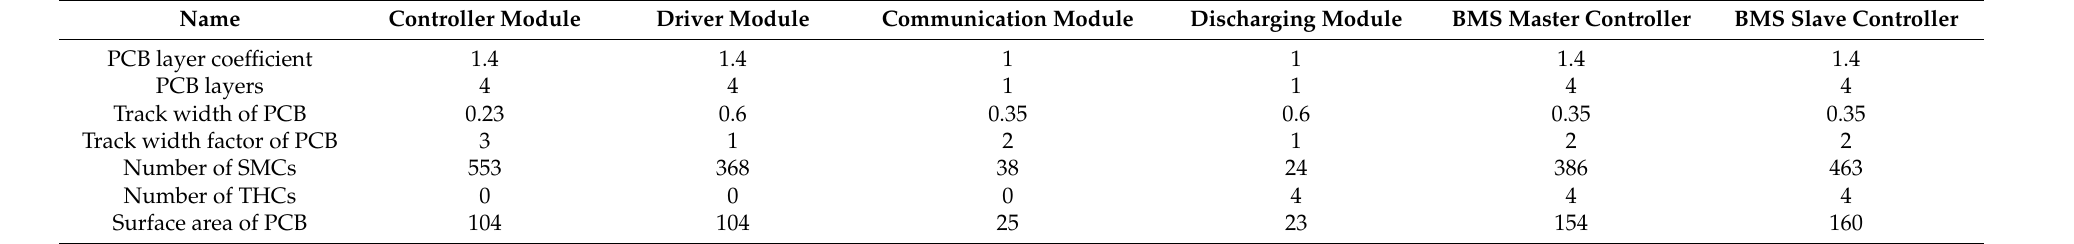
Table A2. Parameters for PCB failure rate